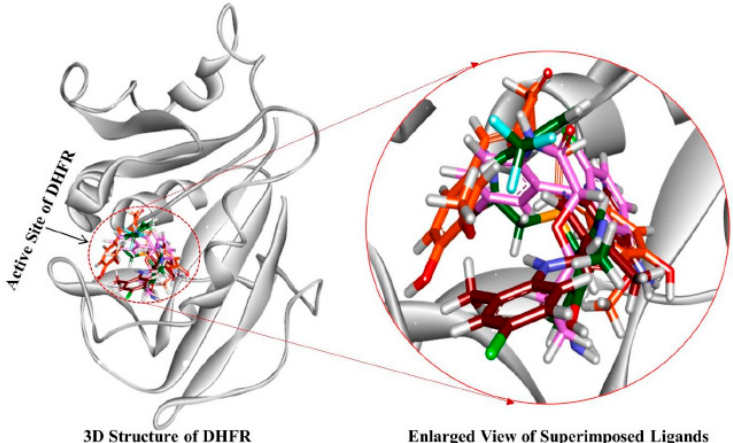
Figure 8. The reference compound and the three hit compounds occupied the active site of hDHFR. All the compounds in their representative structures were superimposed (left) and enlarged (right). 3D structure of hDHFR is shown in light grey color. Red, magenta, green, and orange colors represent the reference compound, Hit1, Hit2, and Hit3, respectively.